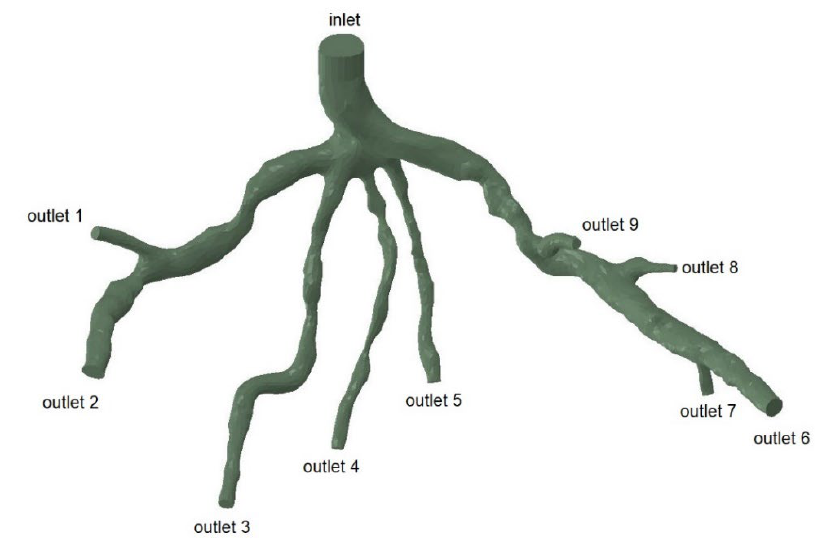
Figure 3. Geometry of inlet and outlets of the CT209 model.